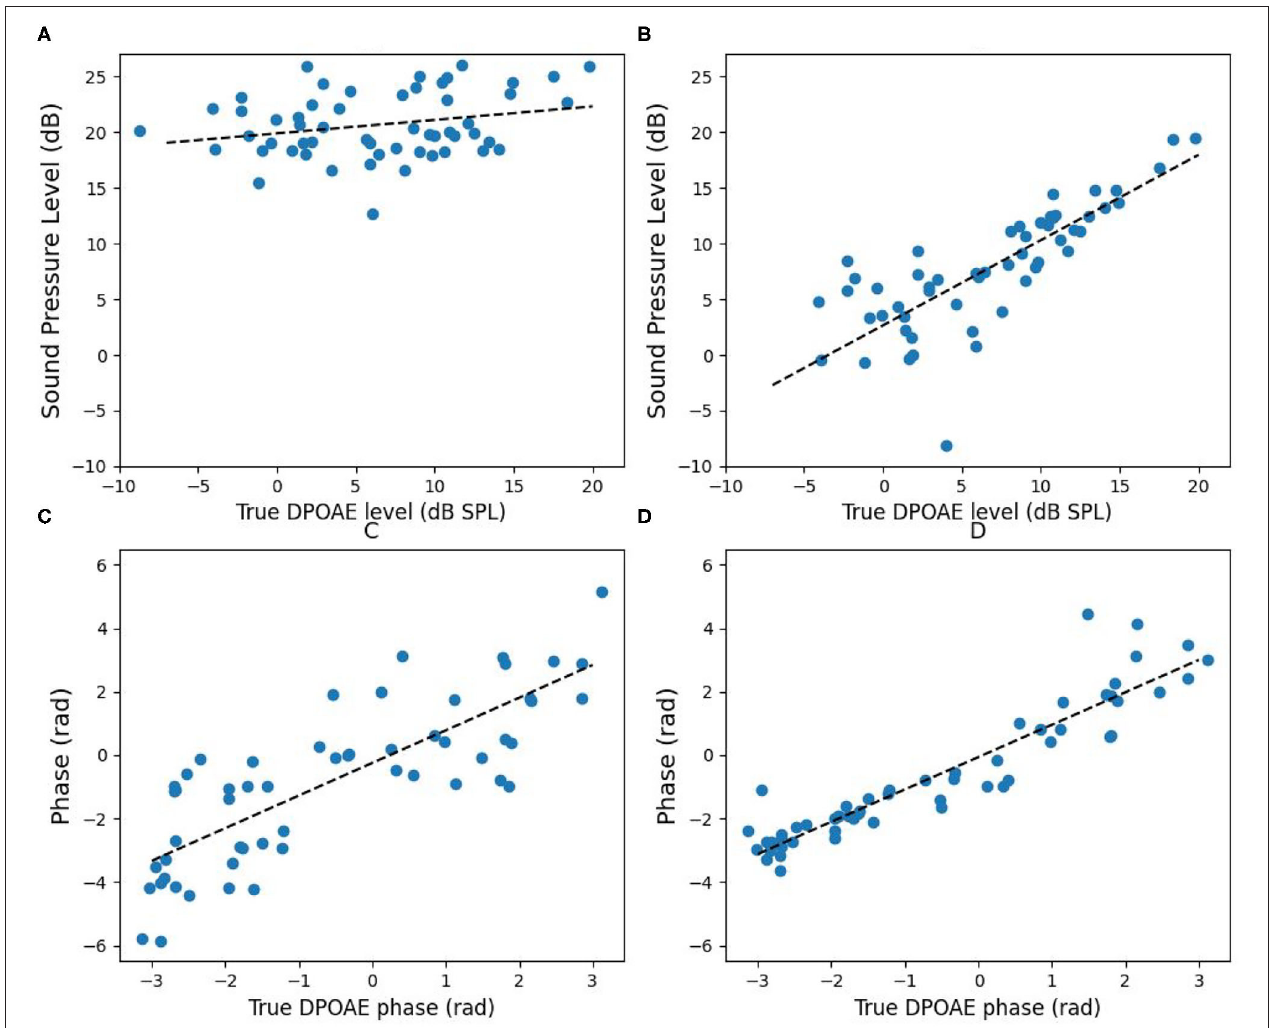
FIGURE 12 | Comparison of DPOAE data without and with the IMD3 cancellation strategy. (A) The sound pressure level without applying the IMD3 cancellation strategy; (B) the sound pressure level after applying the IMD3 cancellation strategy; (C) the phase without, and (D) the phase with the IMD3 cancellation strategy. In each plot, the dashed line shows the result of linear